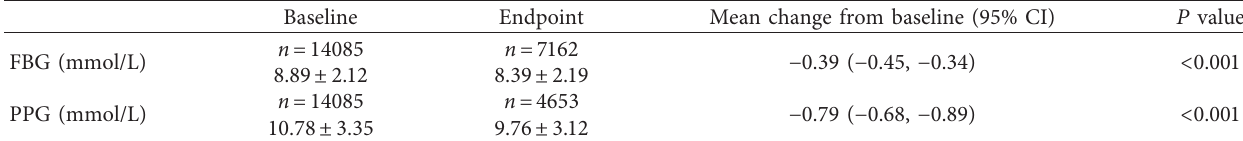
Table 2: Change from baseline at week 12 for primary efficacy (FBG and PPG) measures. Baseline